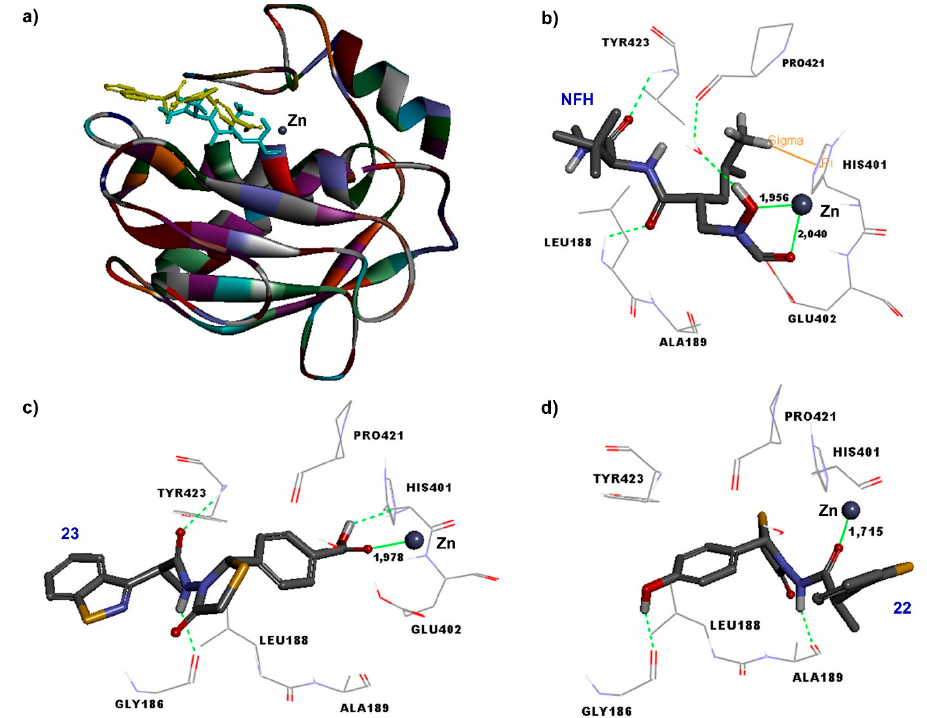
Figure 3. ( a ) Binding modes of 23 (yellow) and NFH (blue); ( b ) Docking position * of NFH: showed hydrogen bonds with Gly186, Leu188, Tyr421(water mediated), Tyr423 and a π –sigma interaction with His401; ( c ) Docking position * of 23 : showed hydrogen bonds with Gln186, Tyr423 and His401; ( d ) Docking position * of 22 : showed hydrogen bonds with Gln186, Ala189. * All hydrogen bonds are shown as green dashed lines and all distances are shown as green lines.